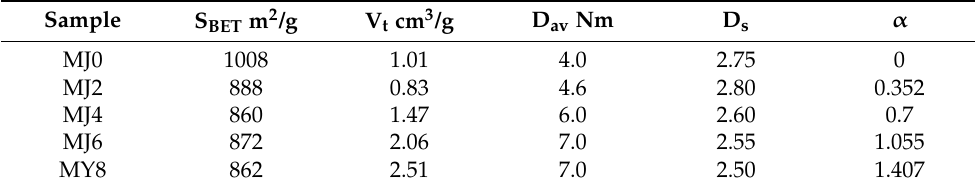
Table 3. Texture properties of the investigated samples. Specific surface area (S BET ), total pore volume (V t ) and associated average pore diameter (D av ), fractal surface dimension (D s ), and hydrophobiza- tion degree ( α ) are